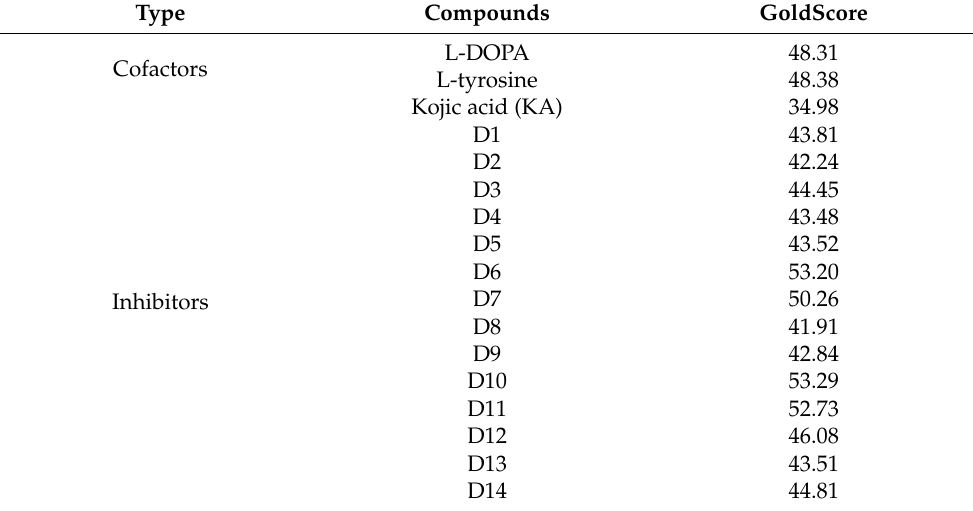
Table 1. Docking scores of the natural substrates (L-DOPA and L-tyrosine) and the inhibitors (KA and the fourteen KA derivatives named D1–D14) of